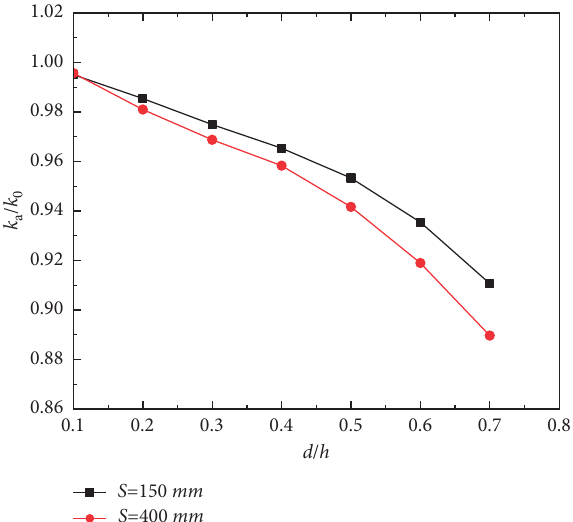
Figure 19: Distortional buckling coefficient of columns with three circular holes in different hole spacings.